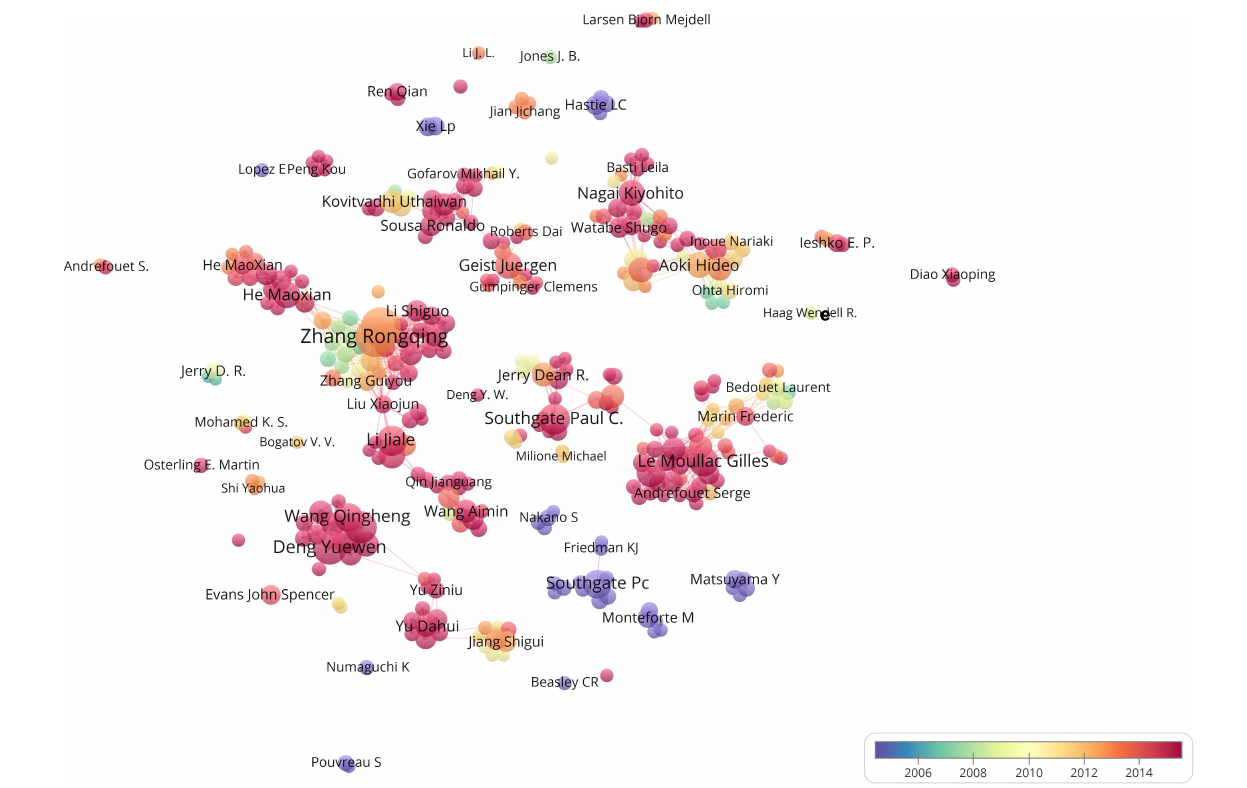
FIGURE 5 | Bibliometric map of the studies of pearl bivalve mollusks as the theme. The size of the dot is proportional to the frequency that a certain author appears in the analyzed articles. A line between two dots means that these two authors appeared in the same article. The positive correlation between the thicker line and the higher frequency indicated that the two authors appeared continually in the same articles. The color stands for the year when a certain author most frequently occurred in articles.